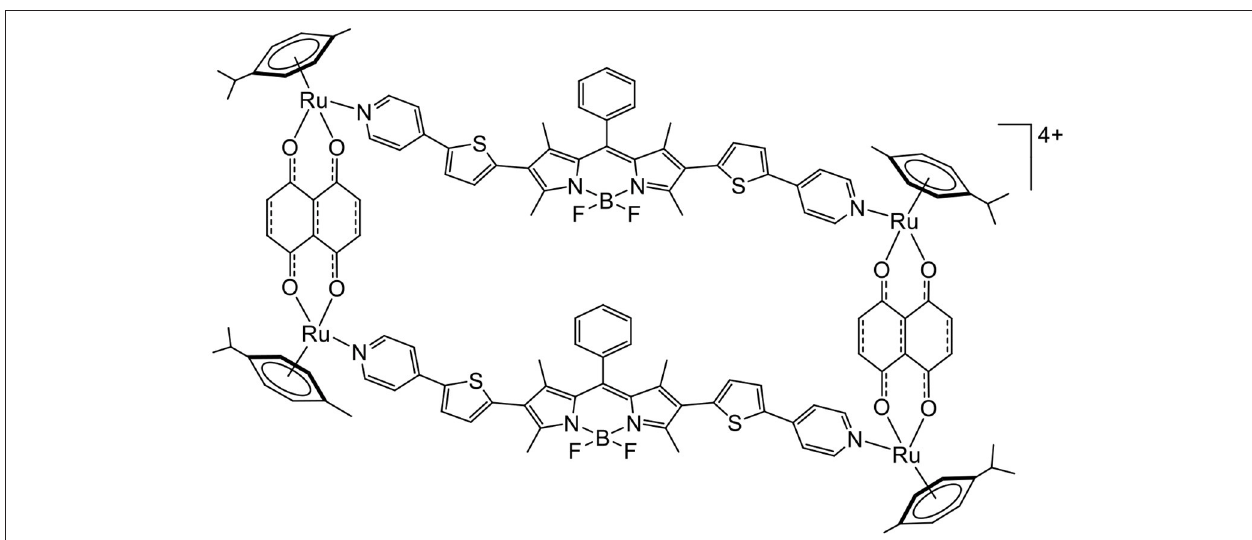
FIGURE 7 | BODIPY-based tetranuclear arene ruthenium metalla-assemblies as potential PDT agent (Gupta et al.,